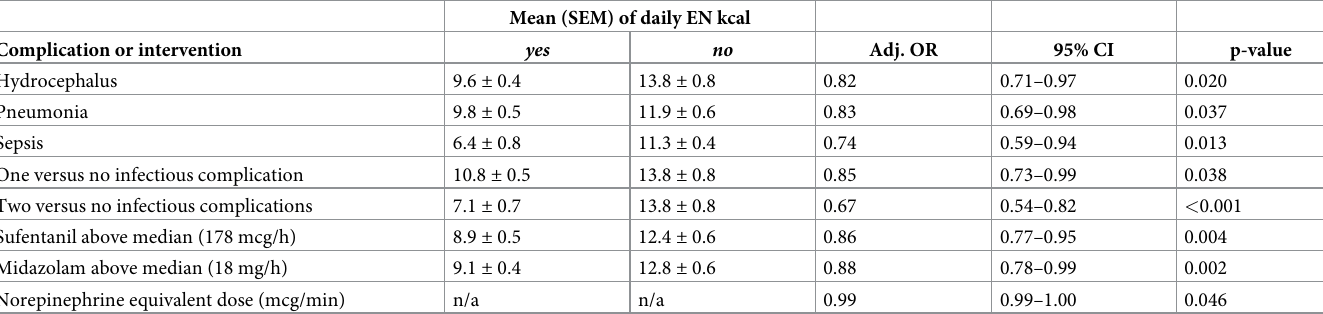
Table 2. Factors associated with impaired enteral